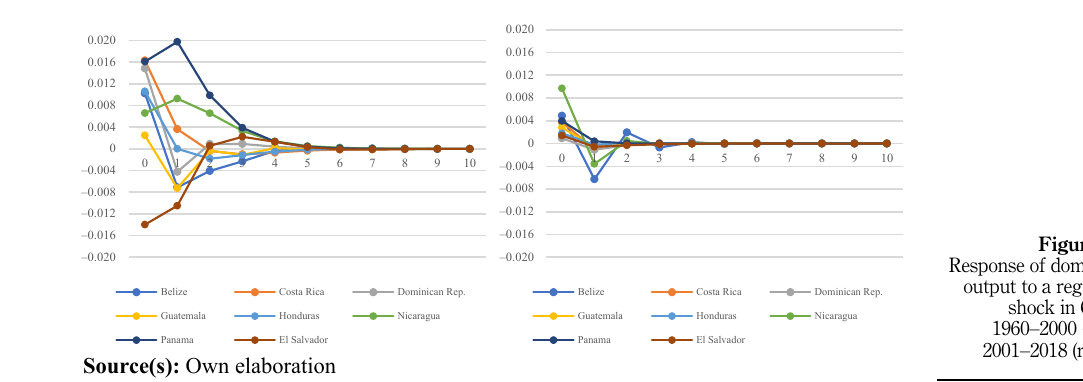
Figure 3. Response of domestic